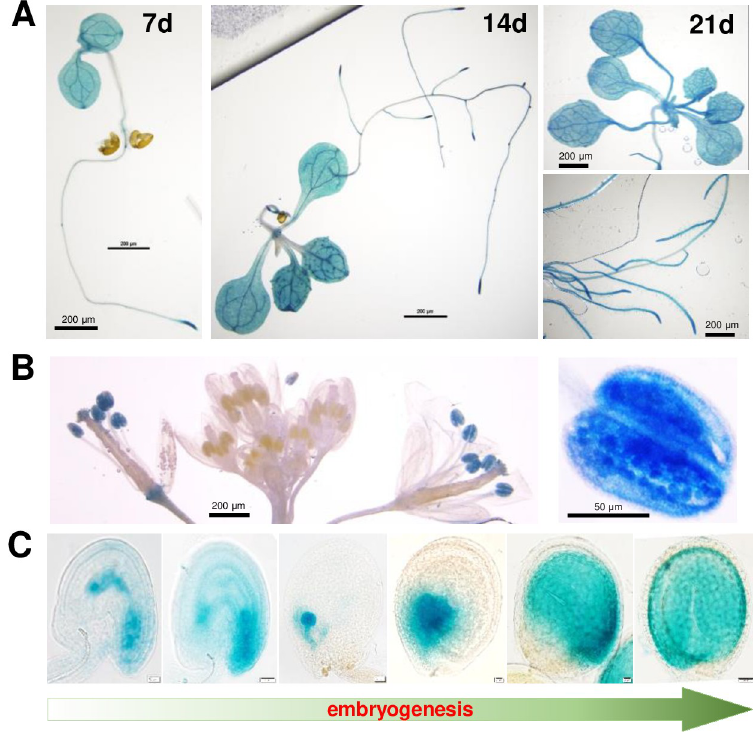
Fig 2. Expression analysis of AtRNH1B in Arabidopsis . GUS staining shows the expression pattern of AtRNH1B in AtRNH1Bpro : AtRNH1B-GUS atrnh1b-1 transgenic plants in different tissues and developmental stages. (A) 7-, 14-, and 21-day-old seedlings. Scale bars, 200 μ m. (B) Open flowers and buds (left) and pollen (right). Scale bars are indicated. (C) Seeds at different developmental stages (unfertilized ovule, fertilized ovule, globular, heart, torpedo, and mature). Scale bars, 20 μ m. GUS, β -glucuronidase enzyme.